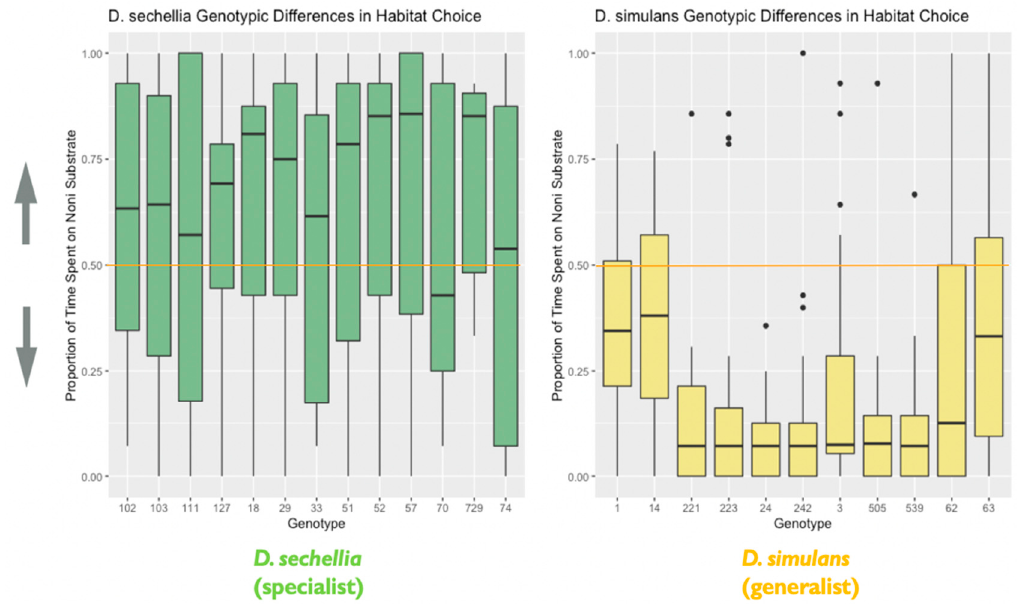
Figure 5. Genotypic differences in habitat choice: the plot represents genotypic differences in habitat (food substrate) choice, as noted in the main text. Data are from the second experiment measuring habitat choice. The y-axis represents the proportion of time spent on the imitation noni substrate. Lower values closer to 0 indicate a habitat preference for the plain substrate, while higher values closer to 1 indicate a habitat preference for the imitation noni substrate. A value on or near 0.5 (marked by the orange line) indicates no demonstrable habitat preference for either the plain or imitation noni substrates ( N = 526 flies). The box in the plot represents the inter-quartile range of scores, including the middle 50% of scores for the group, with the median score represented by the middle quartile mark (or line). The whiskers represent the score ranges outside the inter-quartile range, including the top 25% of scores for the group in the upper whisker, and the bottom 25% of scores in the lower whisker. The dots beyond the whiskers represent outlier values. Our findings indicated that genotypes differed significantly in habitat choice.